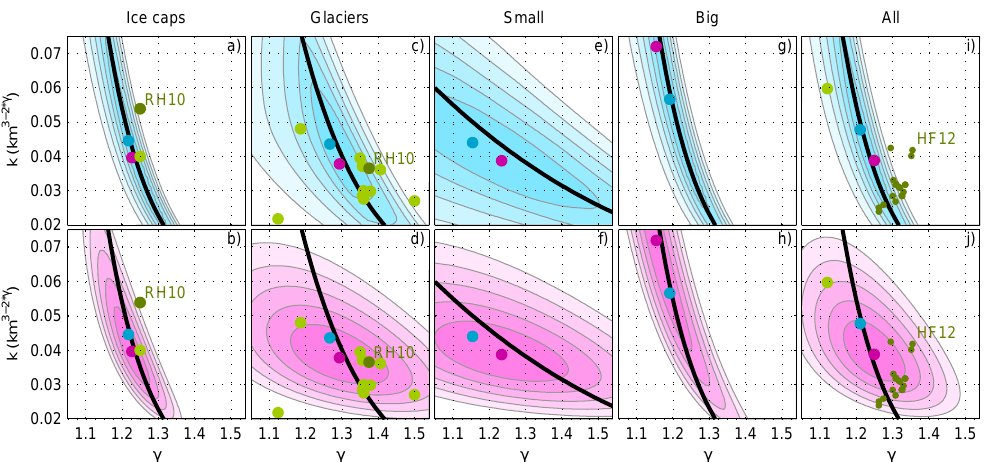
Fig. 3. Area–volume scaling law exponents and coefficients for 5 different groups of glaciers and ice caps. Background shading show the misfit functions contoured for 0.2 increase in the log(misfit). Black lines show the parameter combinations that result in the correct total volume for the calibration volume database. Top row uses a weighted absolute deviation misfit function in cyan, and bottom row uses a squared log volume misfit in magenta. Cyan and Magenta dots show the locations of the corresponding minimum misfit. Green dots show the scaling laws in Table 1 for comparison. The recent RH10 (Radi´c and Hock, 2010) and HF12 (Huss and Farinotti, 2012) scaling laws are highlighted with a darker shade of green. Small and Big use a 25km 2 area